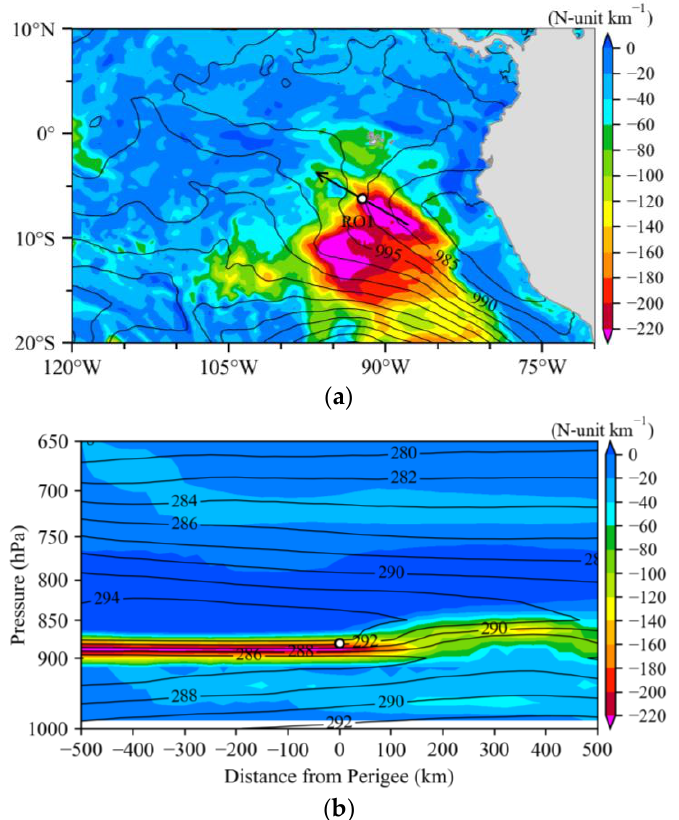
Figure 5. ( a ) Horizontal distribution of the vertical gradient of wet refractivity (shaded) and geopo- tential height (contour, unit: gpm) at 900 hPa, and ( b ) Vertical cross-section of the vertical gradient of wet refractivity (shaded) and the temperature (contour, unit: K). The perigee point of RO1 is shown by a black open circle and the ray tangent direction is shown in (a) by the black arrow. The refractivity gradient is calculated from ERA5 reanalysis at 0700 UTC, 11 August 2020.